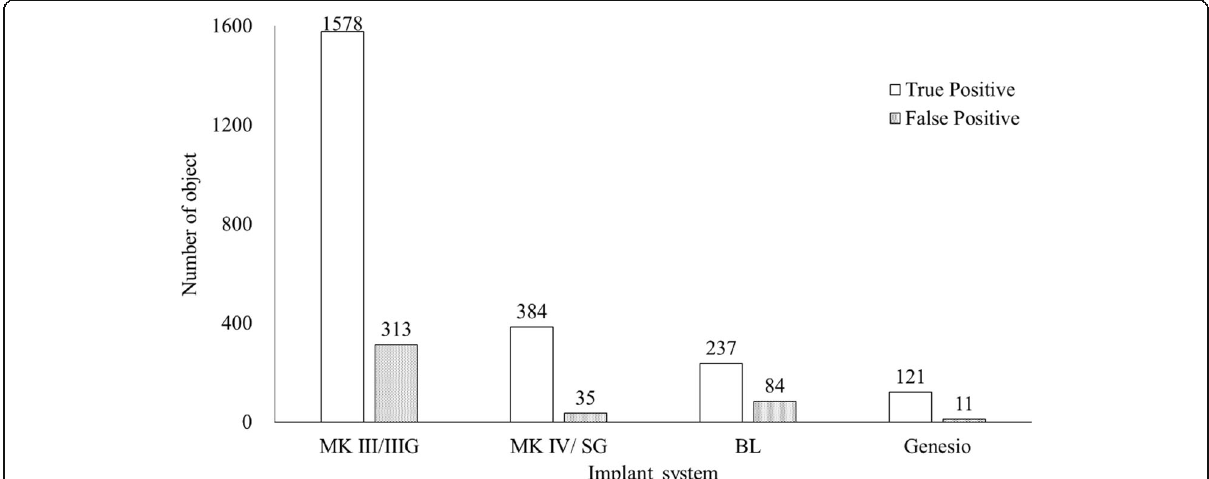
Fig. 3 The total number of implant systems detected correctly (TPs) and those detected as other prostheses (FPs). MK III/MK III Groovy: MK III/IIIG, MK IV/Speedy Groovy: MK IV/SG, bone level: BL and Genesio Plus ST: Genesio